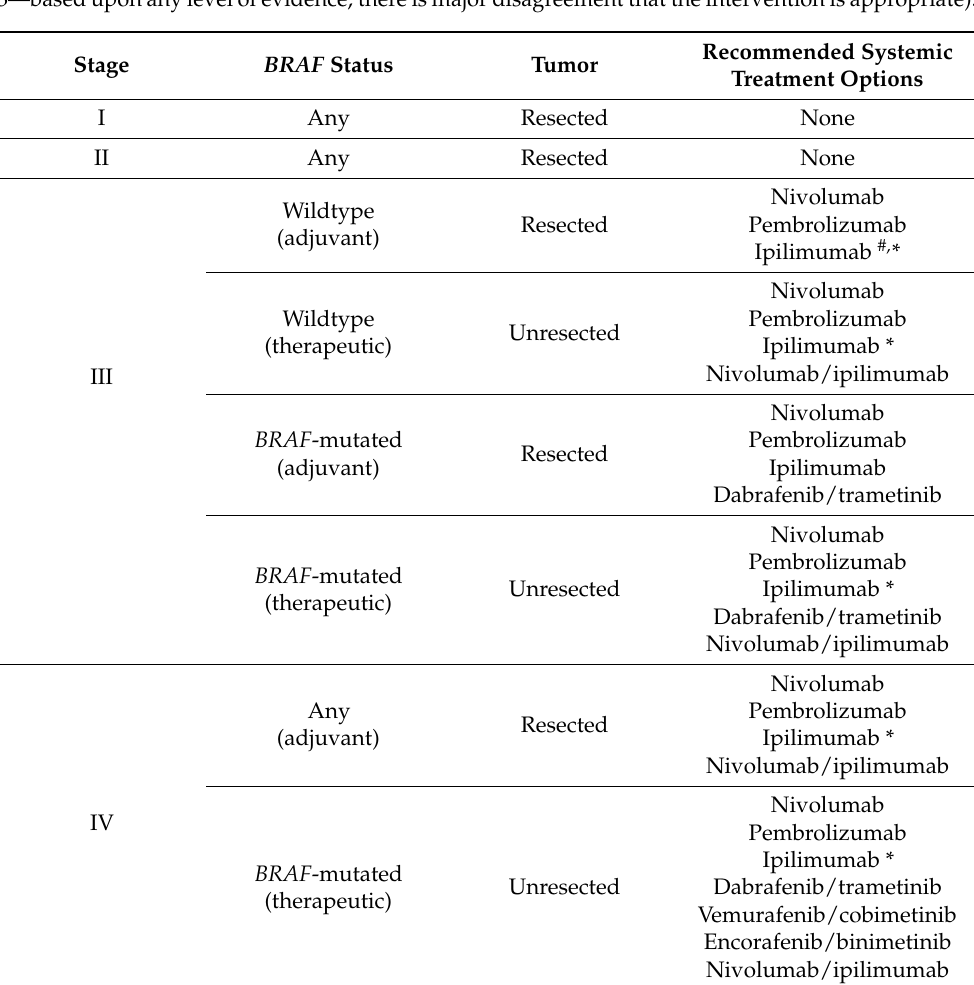
Table 5. Summary of treatment recommendations adapted from the NCCN guidelines. Strength of recommendations are between 1 and 2A. (NCCN Recommendation Categories: 1—based upon high level-evidence, there is uniform NCCN consensus that the intervention is appropriate; 2A—based upon lower-level evidence, there is uniform NCCN consensus that the intervention is